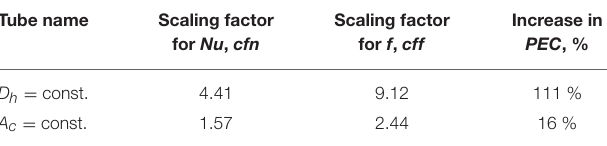
TABLE 2 | Scaling factors for Nu and f for double corrugated tubes compared to the equivalent straight tube and increase in PEC in region of Re from 1,000 to